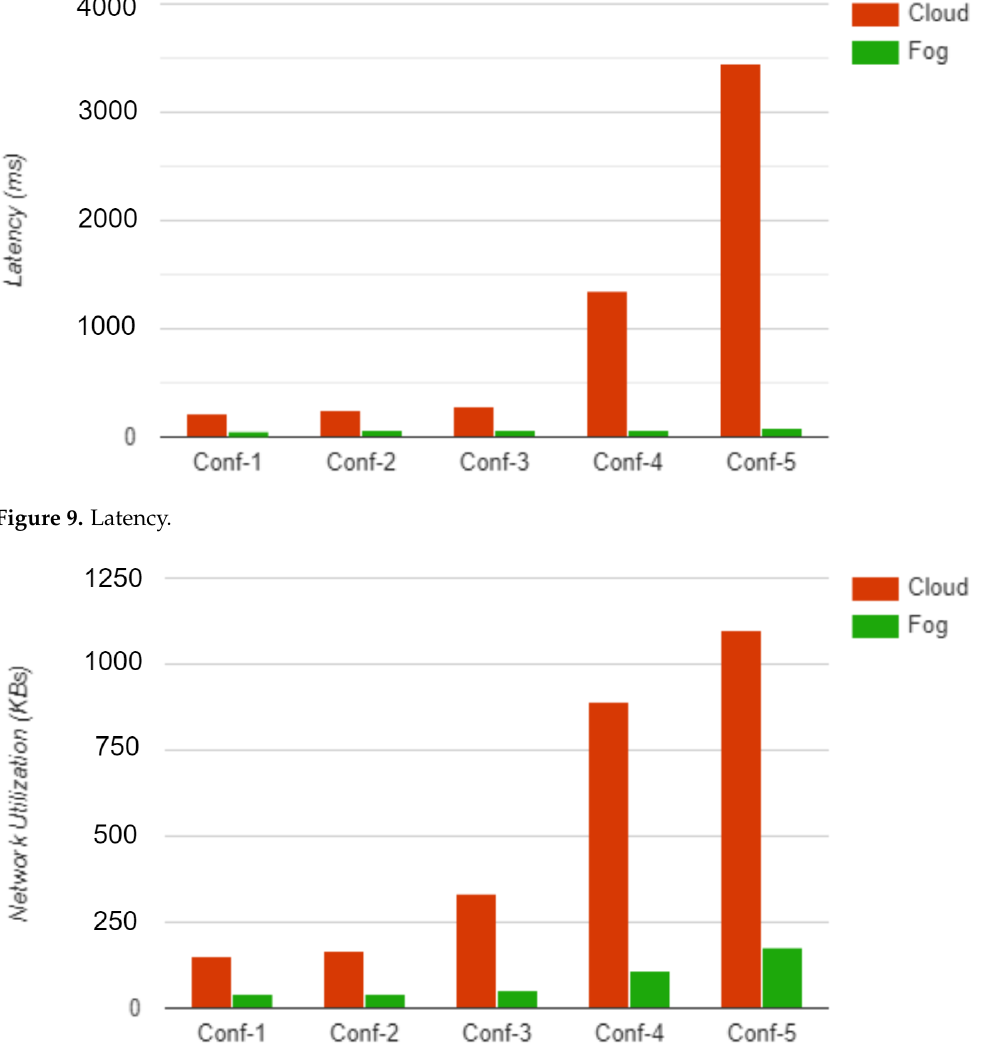
Figure 10. Network